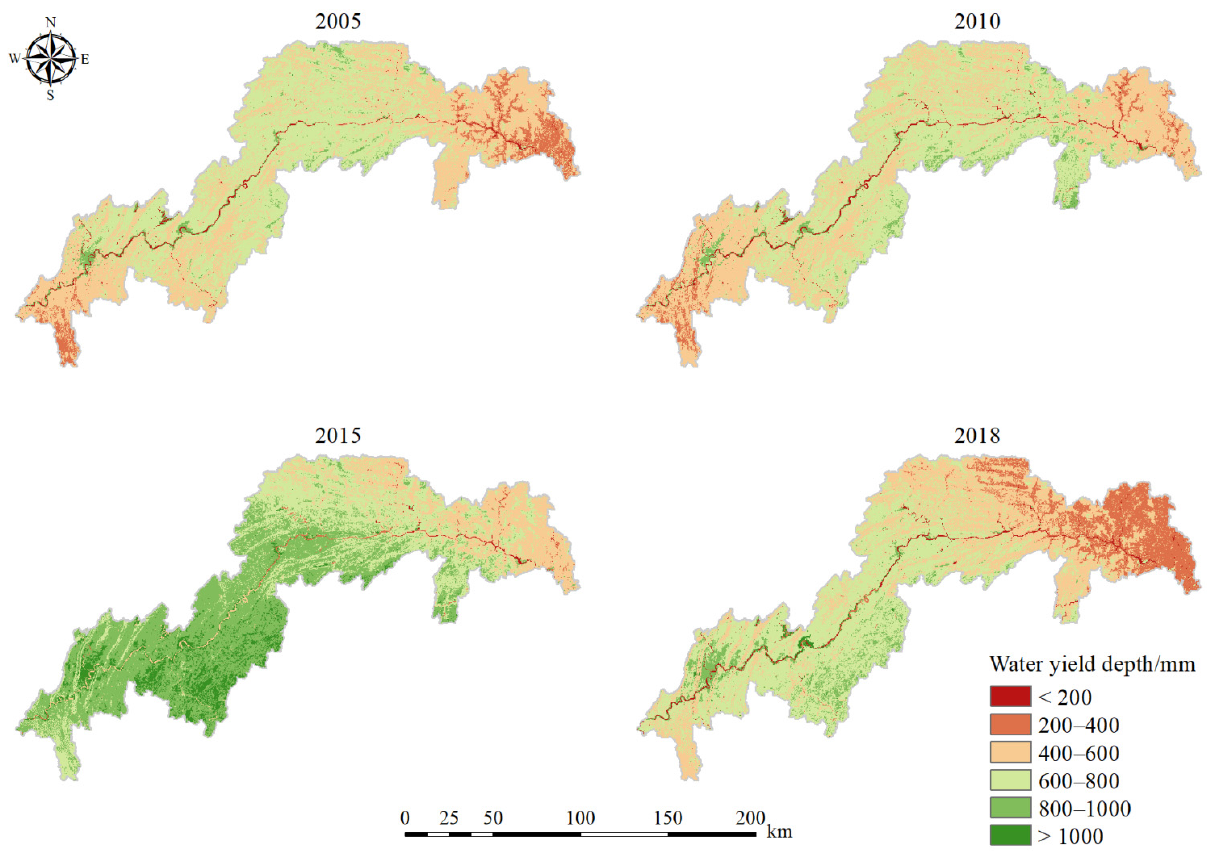
Figure 5. Spatiotemporal distribution of water yield depth in the Three Gorges Reservoir Area from 2005 to 2018.